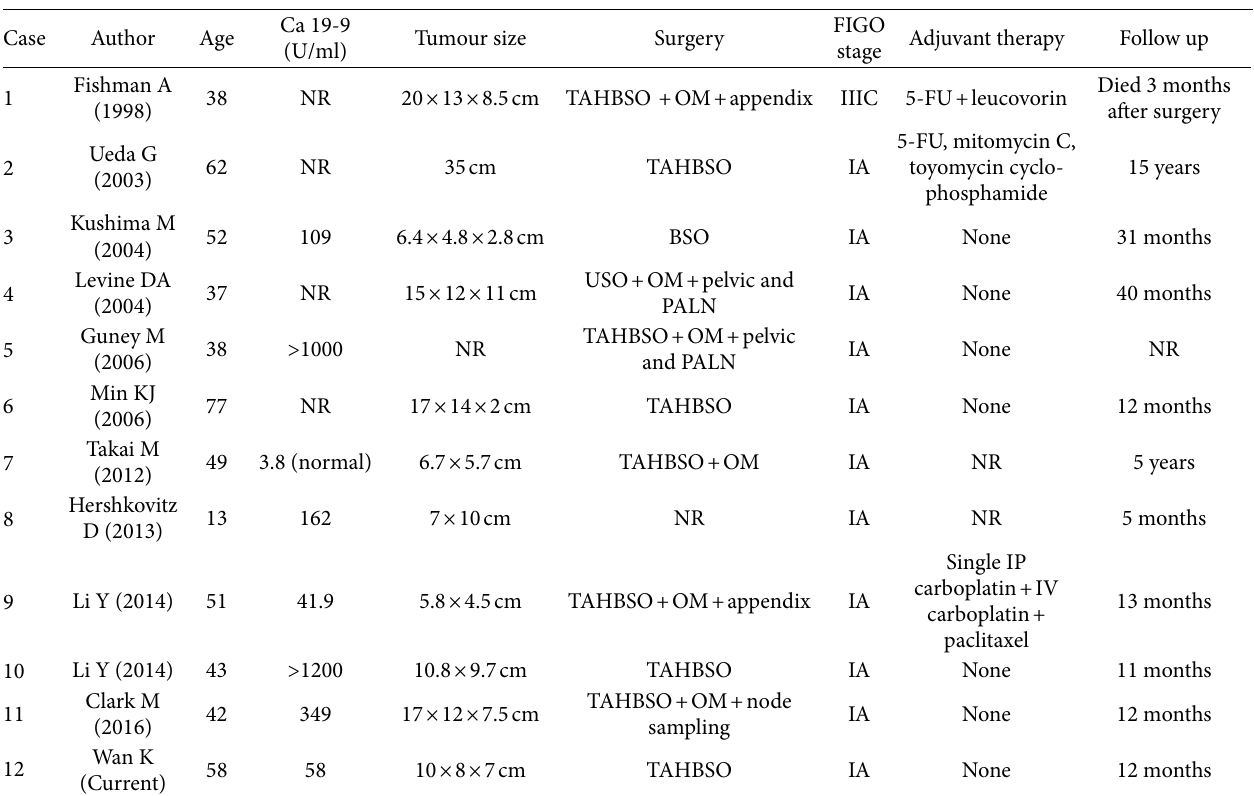
Table 1: Reported cases of intestinal adenocarcinoma arising from a mature cystic teratoma (TAH: total abdominal hysterectomy, BSO: bilateral salpingo-oophorectomy, OM: omentectomy, APT: appendectomy, PALN: Para-aortic lymphadenectomy, 5-FU: 5-fluorouracil, FAMT: 5-fluorouracil + endoxan + mitomycin-C + toyomycin, P + C: paclitaxel + carboplatin. NR: not